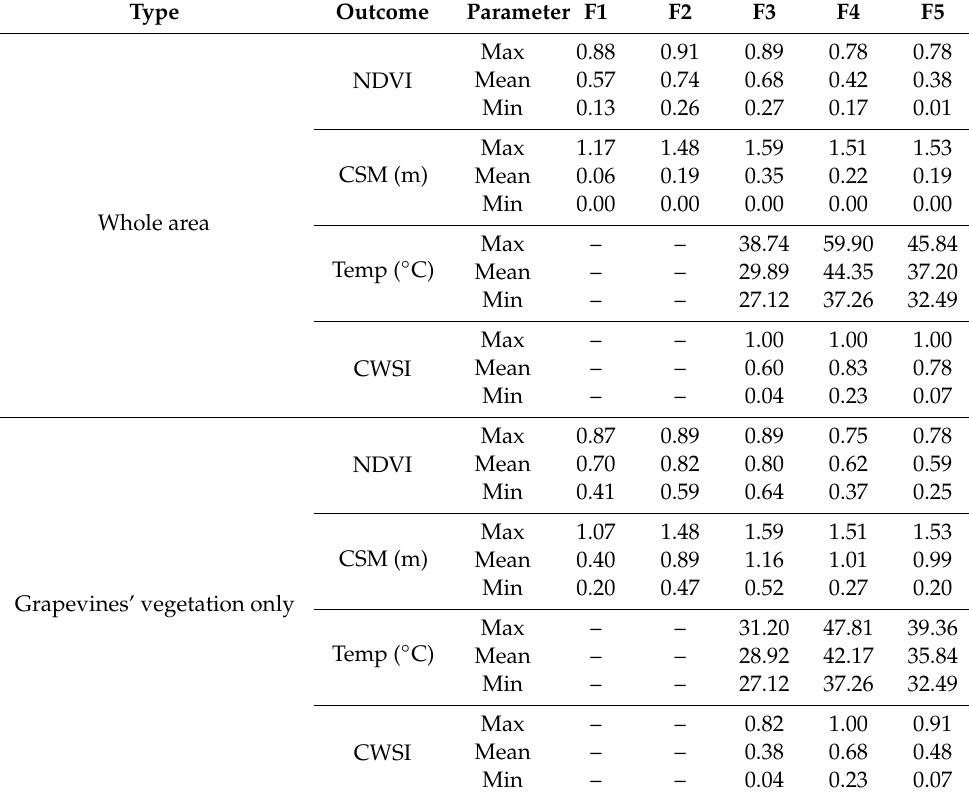
Table 1. Maximum, mean, and minimum values of the normalized di ff erence vegetation index (NDVI), crop surface model (CSM), surface temperature, and crop water stress index (CWSI) when considering the whole vineyard plot and only grapevines’ vegetation in the five flight